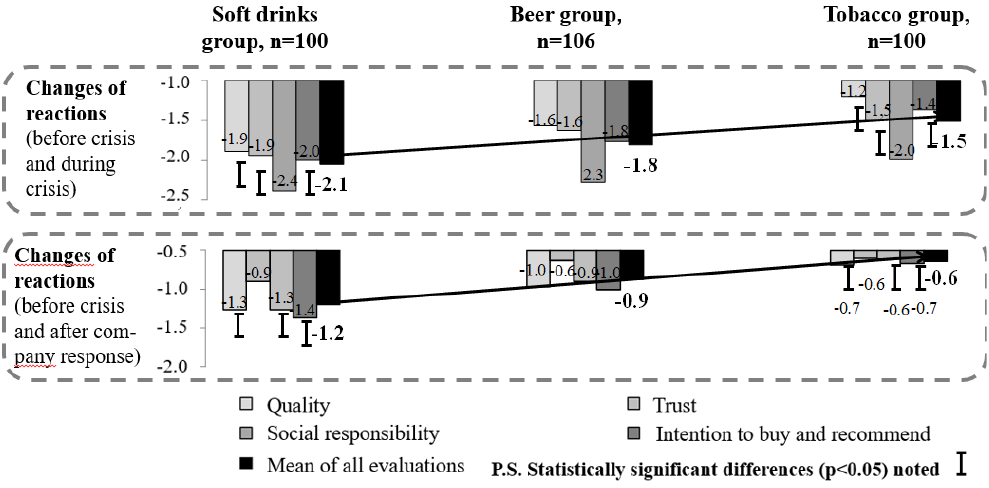
Fig. 2. The difference of the change of consumers’ reactions between the